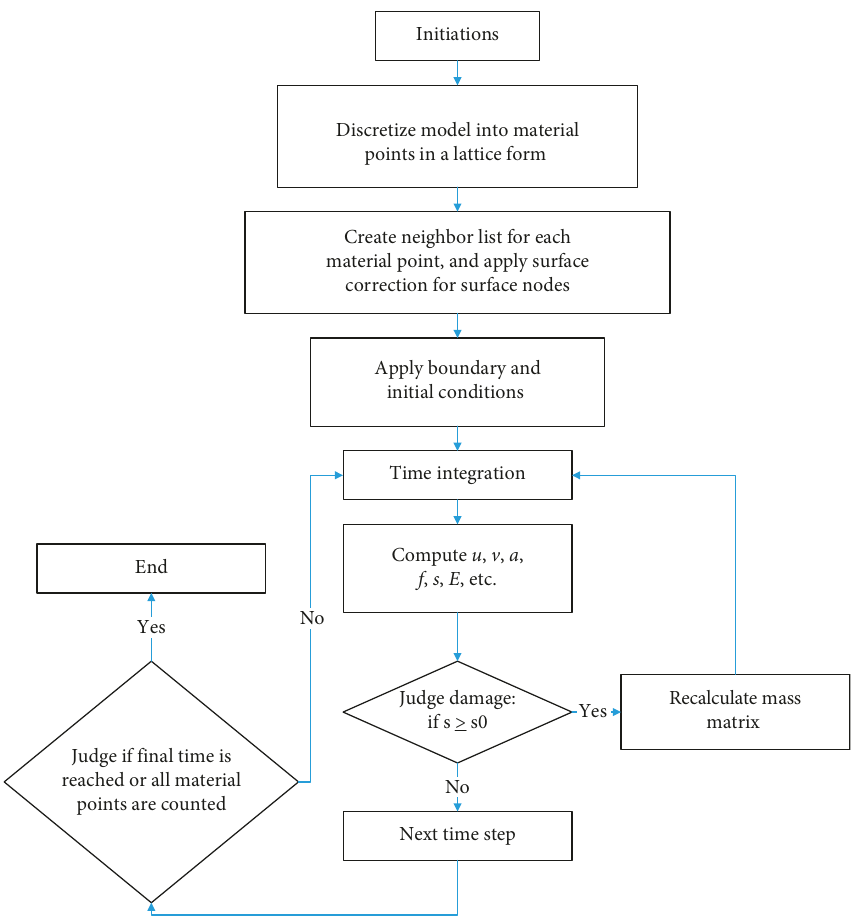
Figure 10: Flow chart of the PDLM algorithm.